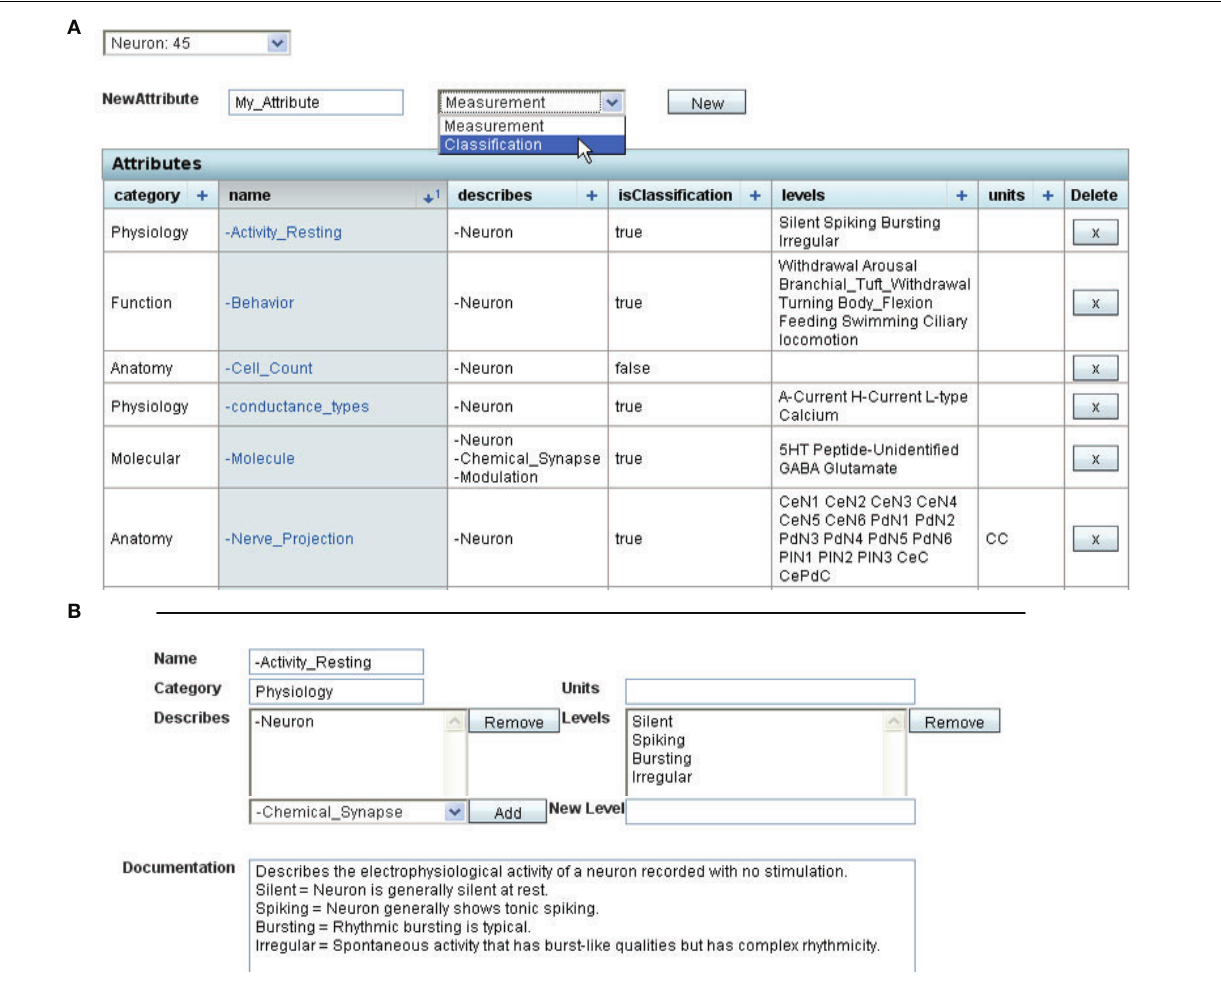
a Classifi cation . Clicking on the attribute’s name allows further editing. (B) This is an example of editing the Attribute “Activity_Resting”. This is a classifi cation with the values Silent, Spiking, Bursting, Irregular. Additional values can be added if they are needed for describing neuronal resting